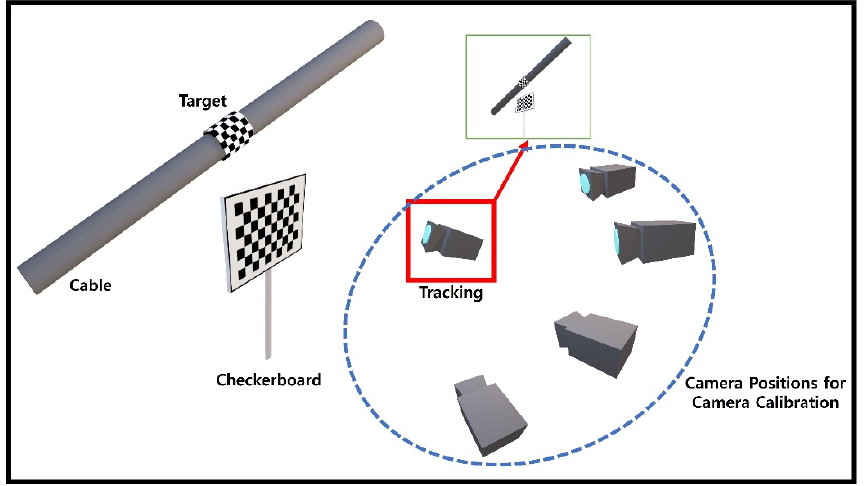
Figure 3. Configuration of Camera Calibration.